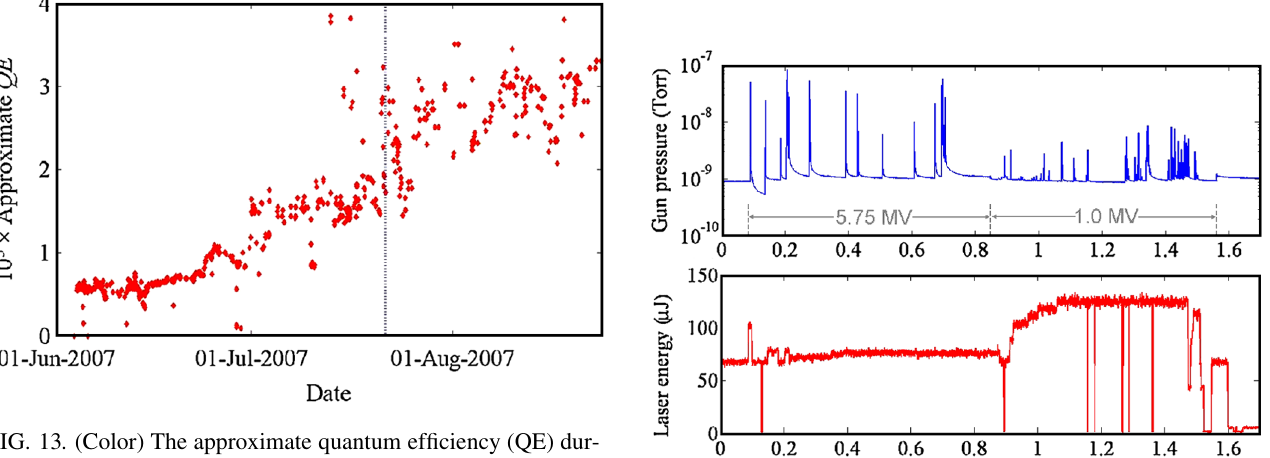
FIG. 13. (Color) The approximate quantum efficiency (QE) dur- ing the past three months of commissioning. The vertical line indicates July 21 when the cathode was lightly cleaned with the drive laser at a higher fluence. The large scatter here is due to the crude (temporary) method used for this routine estimate, which is executed with each Schottky scan.